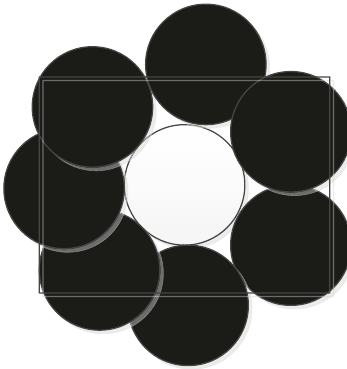
Figure 3: A situation of the second type of